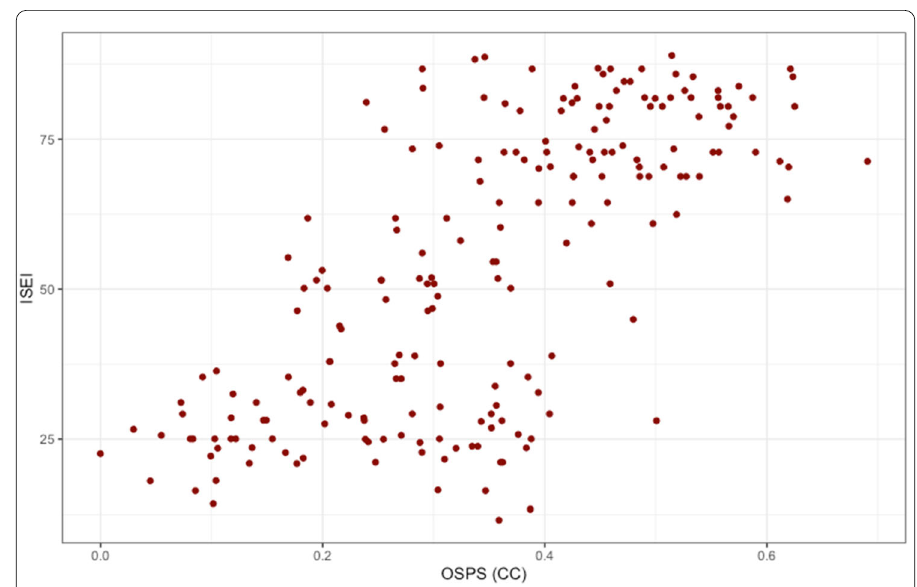
Figure 2 Scatterplot of word embedding based occupation prestige score (Occupation Semantic Position Scale—OSPS) from the CC vector space and